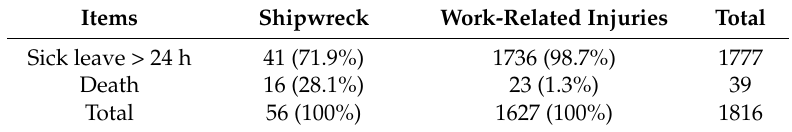
Table 2. Reported shipwrecks, work-related injuries, and their consequences in the period 1998–2016.